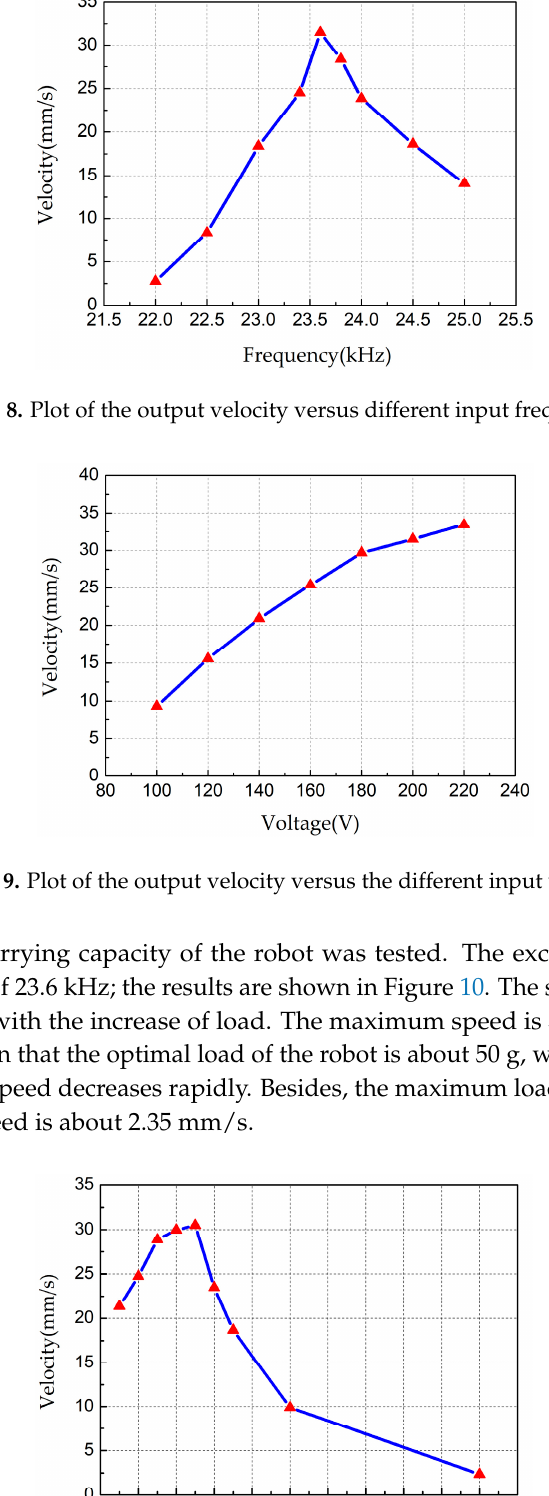
Figure 10. Plot of the output velocity versus different loads.